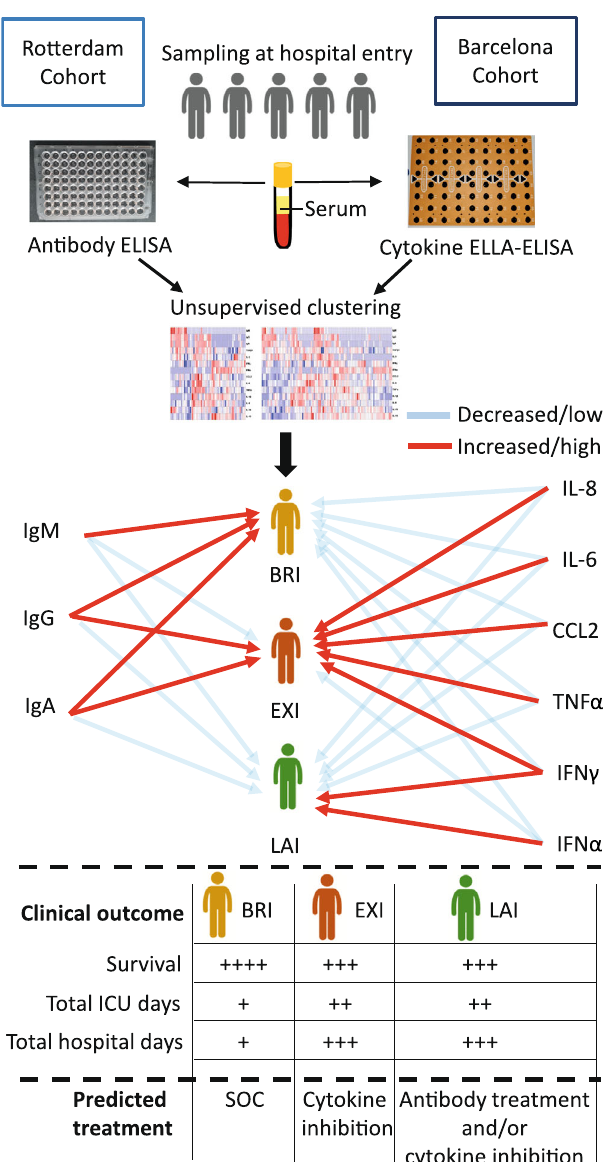
Fig. 7 Unsupervised clustering de fi nes three immunotypes at hospital entry that predict clinical outcome. Anti-SARS-CoV2 nucleocapsid antibodies (IgM, IgG, IgA) and the most prominent anti- and pro- in fl ammatory cytokines out of n = 14 shown. BRI: balanced response immunotype; EXI: excessive in fl ammation immunotype; LAI: low antibody immunotype; SOC: standard of